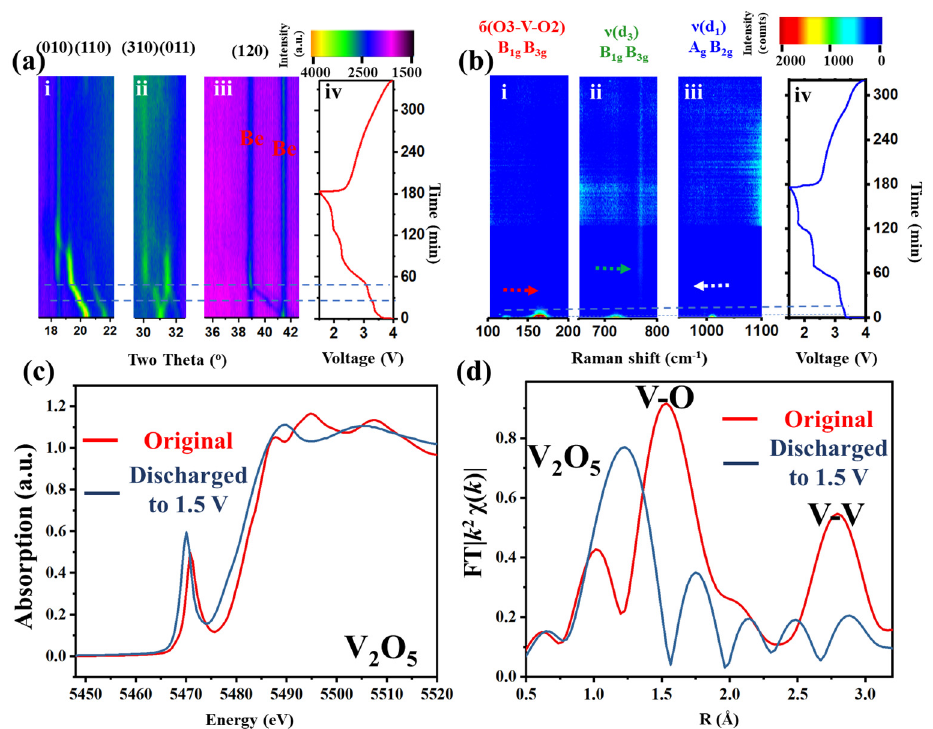
Figure 1. The selected image plot of in situ XRD patterns (a) and Raman spectra (b) of V 2 O 5 within 108 potential window of 1.5–4.0 V at 100 mA g − 1 . Ex situ V K-edge XANES ( c ) and EXAFS ( d ) results of the potential window of 1.5 – 4.0 V at 100 mA g -1 . Ex situ V K-edge XANES (c) and EXAFS (d) results 109 pristine V 2 O 5 and the discharged of the pristine V 2 O 5 and the discharged sample. 110